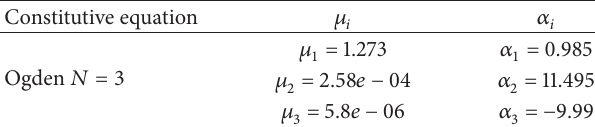
Table 2: The coefficient of material law (after optimized evaluation). Constitutive equation